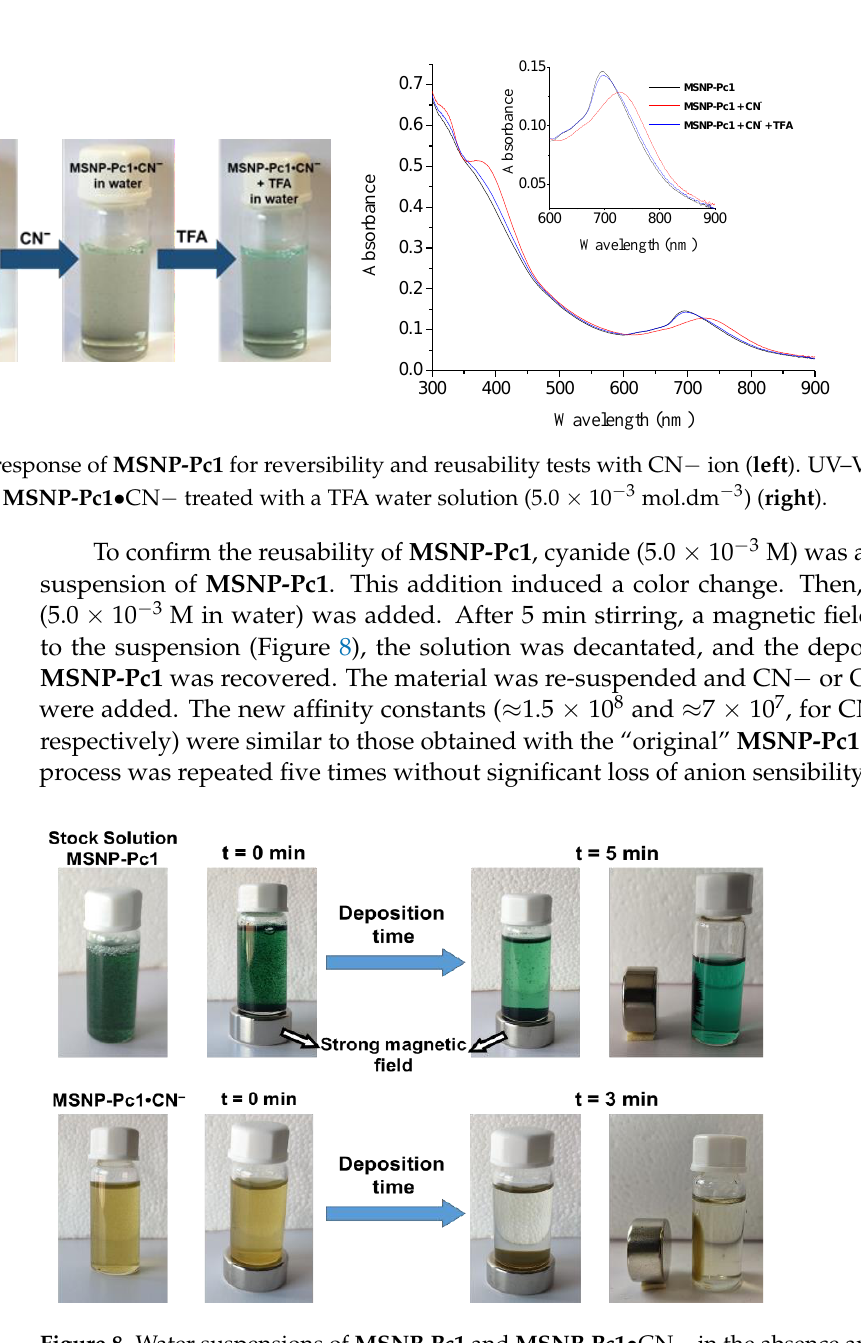
Figure 8. Water suspensions of MSNP-Pc1 and MSNP-Pc1 •CN− in the absence and presence of a strong magnetic field, with their corresponding deposition times.